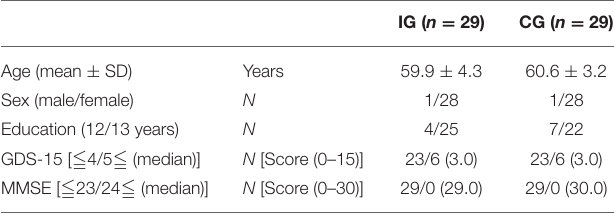
TABLE 1 | Baseline characteristics in both intervention and control